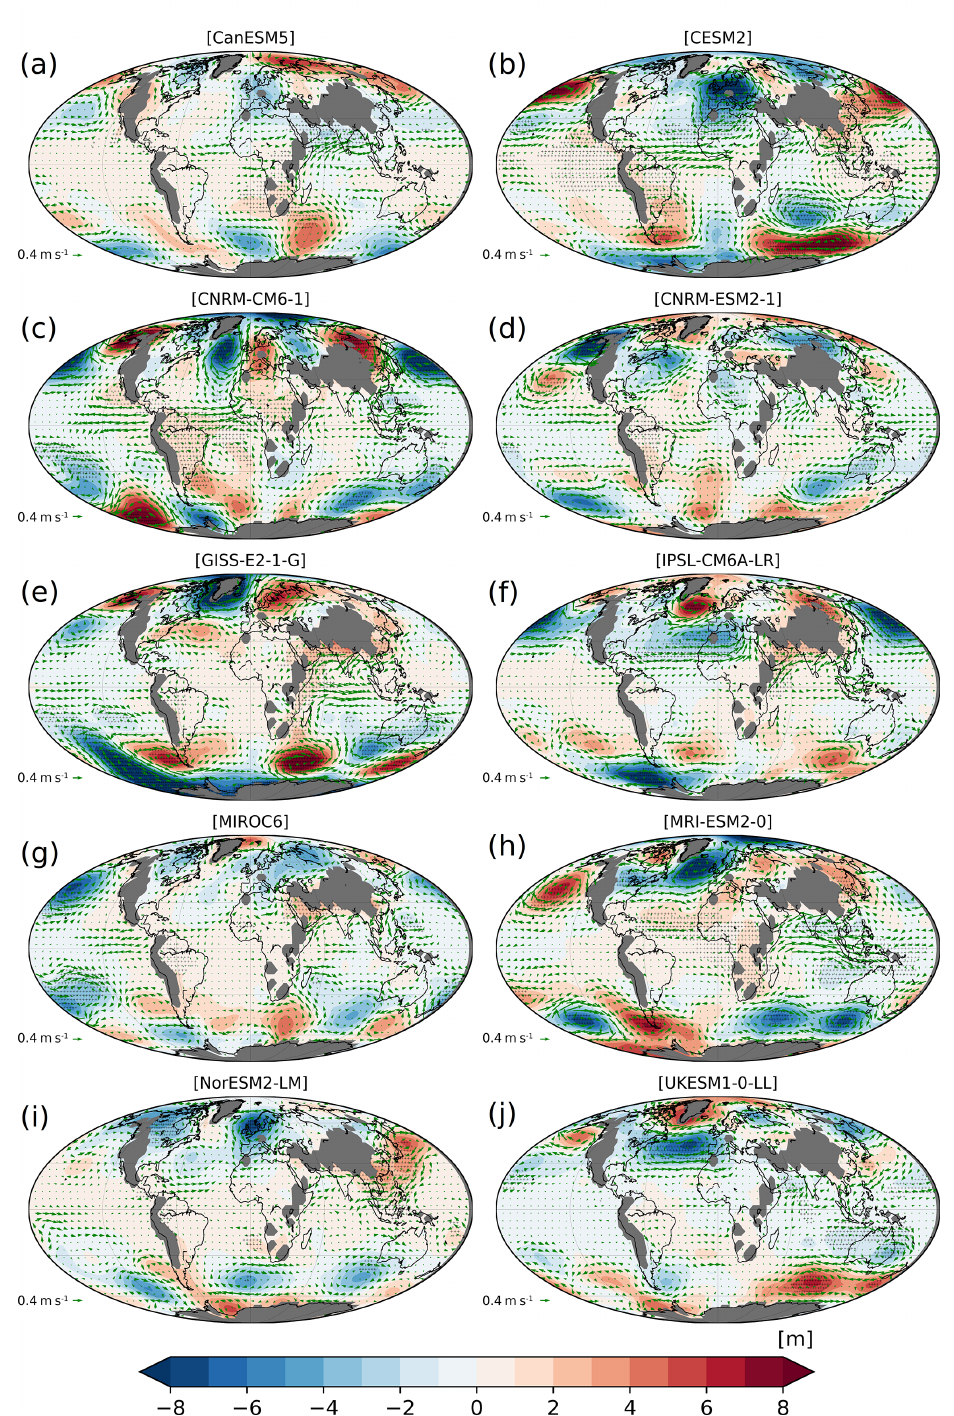
Figure 11. Annual differences between piClim-aer and piClim-control in geopotential height (m) and wind vectors at the 850hPa pressure level for each one of the models used for the ensemble. The dot shading indicates areas in which the differences are statistically significant at the 95% confidence level. Areas with surface pressure lower than 850hPa are masked with grey